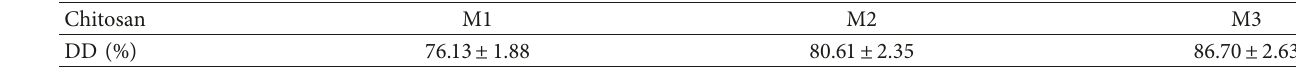
Table 1: DD values of the